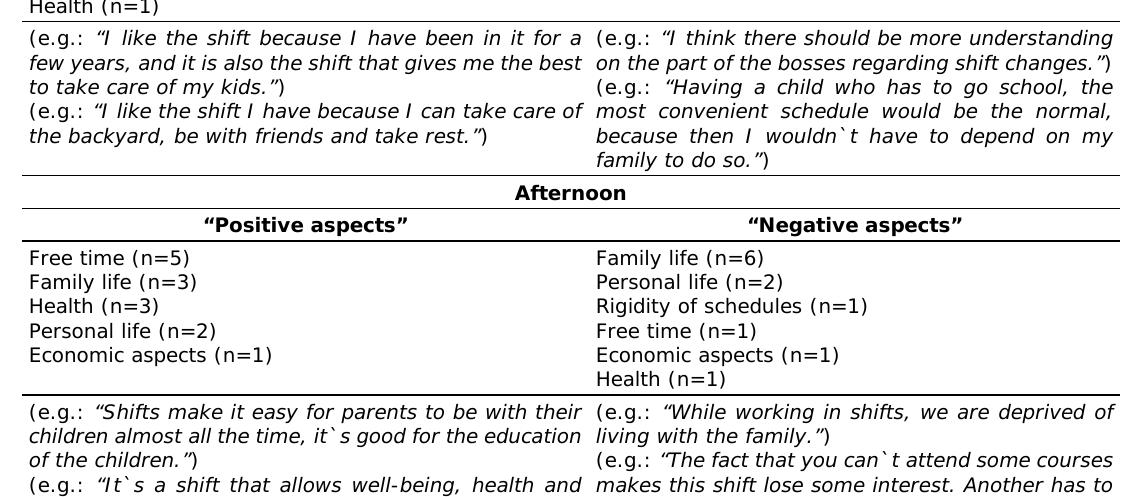
Table 4. Subcategories of “positive aspects” and “negative aspects” on each shift. “Positive aspects” “Negative aspects” Free time (n=6) Personal life (n=3) General (n=3) Family life (n=1) Health (n=1)